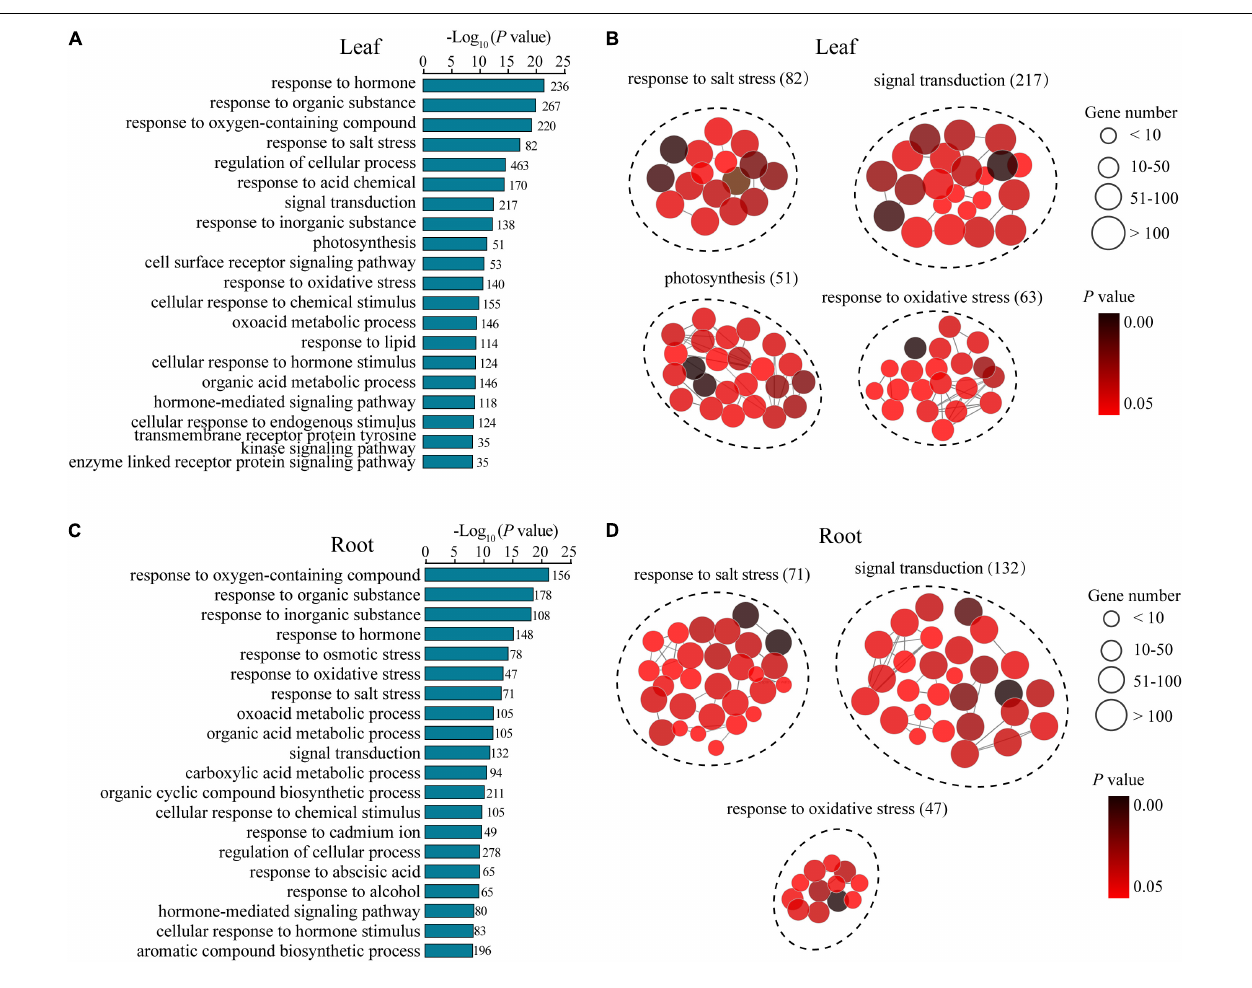
FIGURE 3 | The Gene Ontology (GO) enrichment analysis of the differentially expressed genes (DEGs) in leaves and roots. (A,B) the GO terms of the DEGs generated from comparison R7SL vs. S4SL in leaves. (C,D) the GO terms of the DEGs generated from comparison R7SR vs. S4SR in